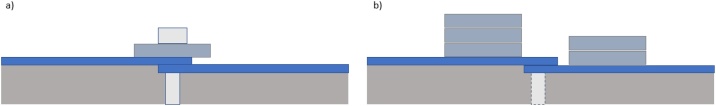
(a) Initial clamping setup using the alignment holes and (b) weighted clamping setup presented along x-axis.